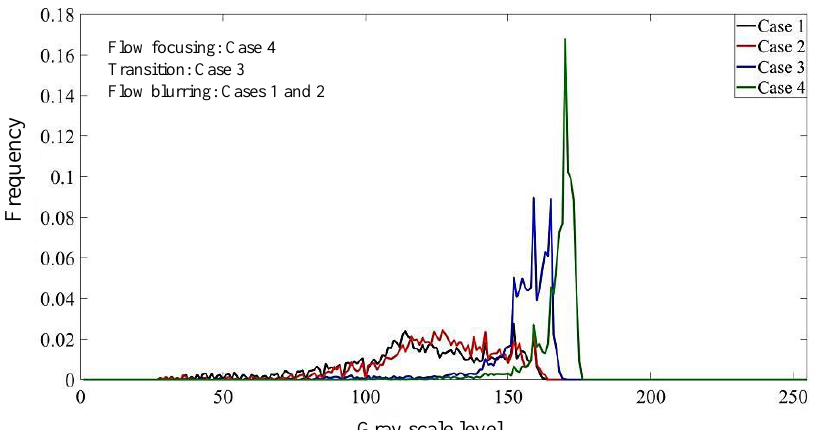
Figure 12. The gray distribution curves of the two-phase flow images under different air flow rate and tube hole distances: the water flow rate and orifice diameter are 100 mL/min and 5 mm. Based on case 1, the air flow rate and tube hole distances in cases 1 to 4 can be dimensionless into (In the form of air flow rate/tube hole distance):1/1, 2/2, 3/3 and